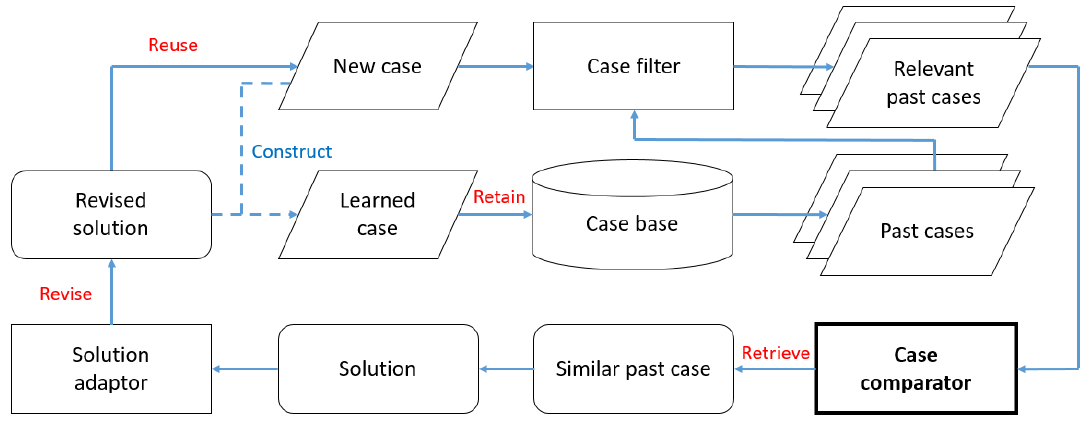
Figure 7. Framework of case-based reasoning (CBR)-based ADSS.